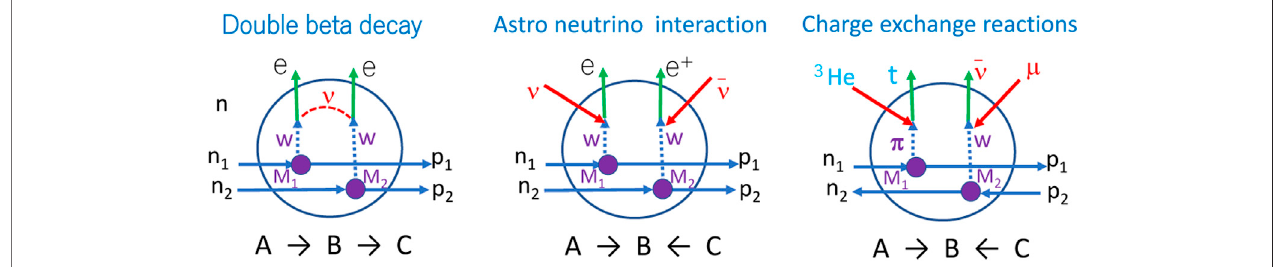
FIGURE1| Decayandinteractionschemes. (A) :Doublebetadecay. (B) :Astro-neutrinoandastro-antineutrinointeractions. (C) :Nuclear( 3 He)andleptonic(muon) charge-exchange reactions (CERs). W and π are weak boson and pion involved in the weak and nuclear CERs,